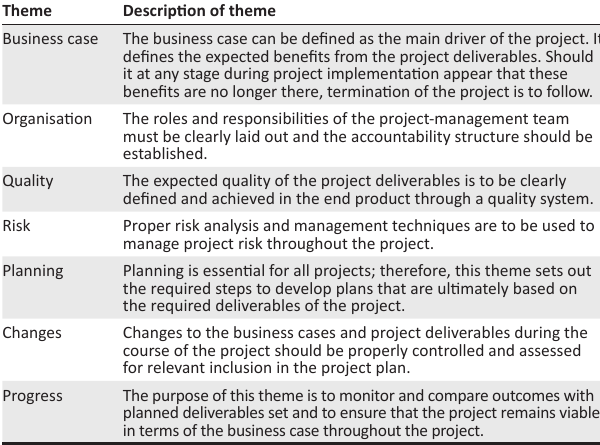
TABLE 2-A1: The seven themes of Projects in Controlled